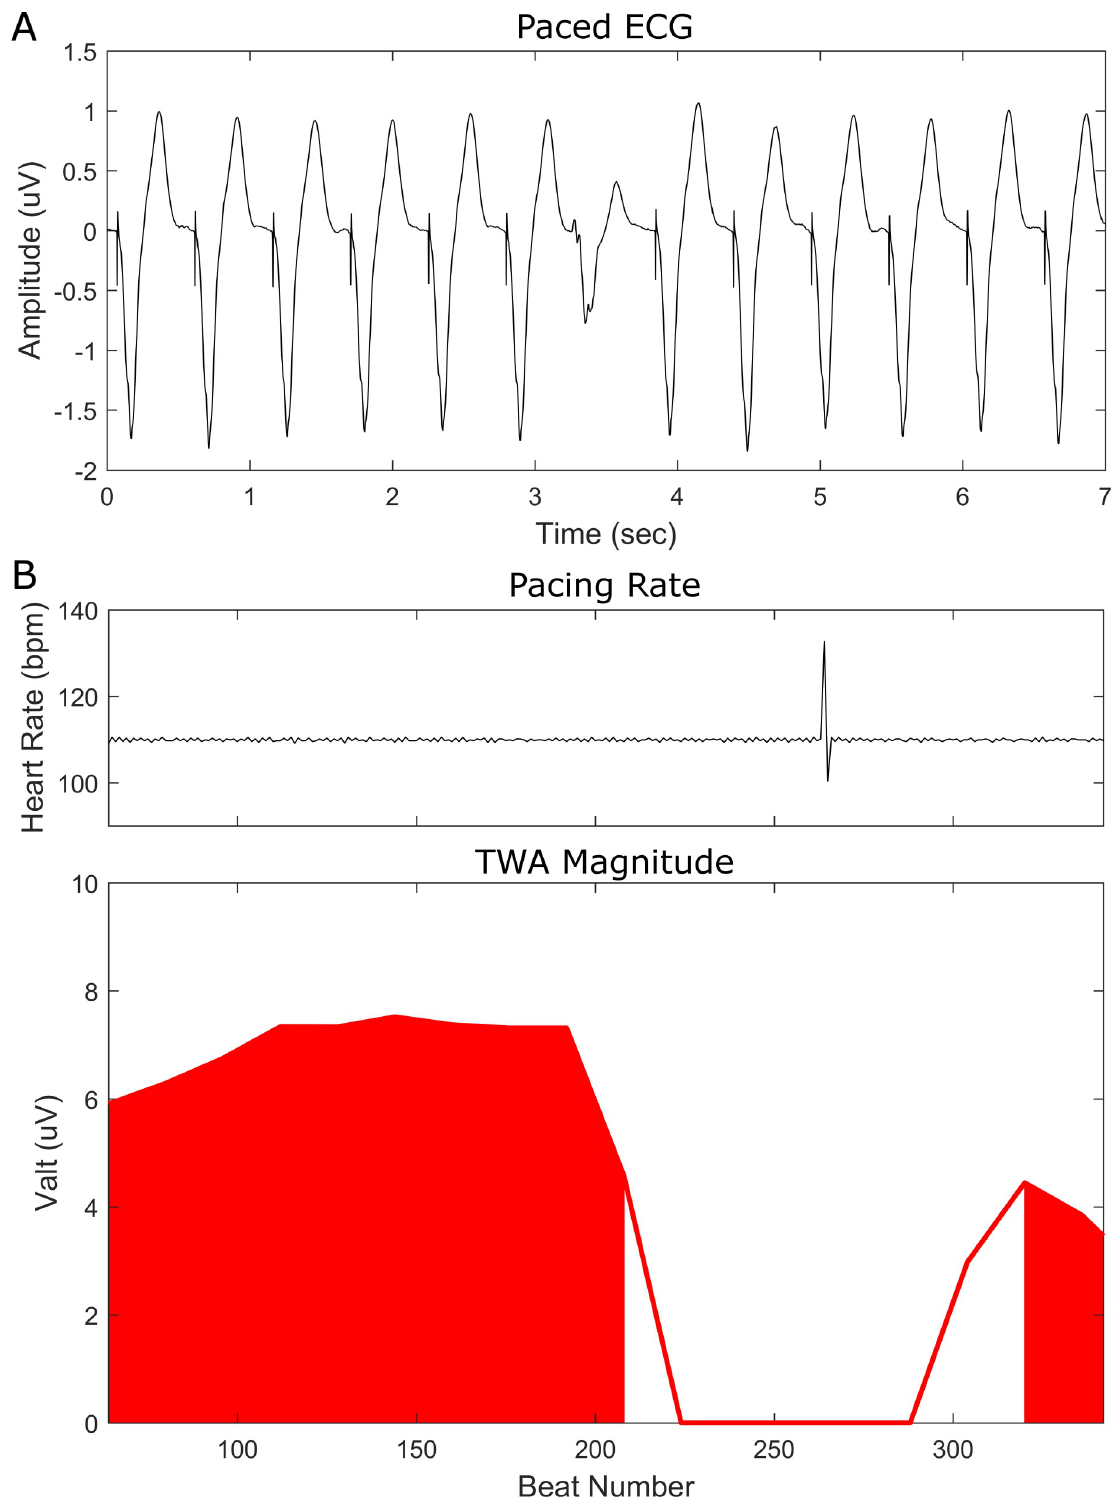
Fig 8. (A) ECG depicting a premature ventricular ectopic beat during atrioventricular pacing at 110 bpm in a precordial lead of a representative patient. (B) Illustration of TWA nullification (lower panel) associated with the region surrounding the ectopic beat (upper panel) and the attenuation of TWA magnitude post ectopic. The red shaded regions indicate V alt values with a k � 3.